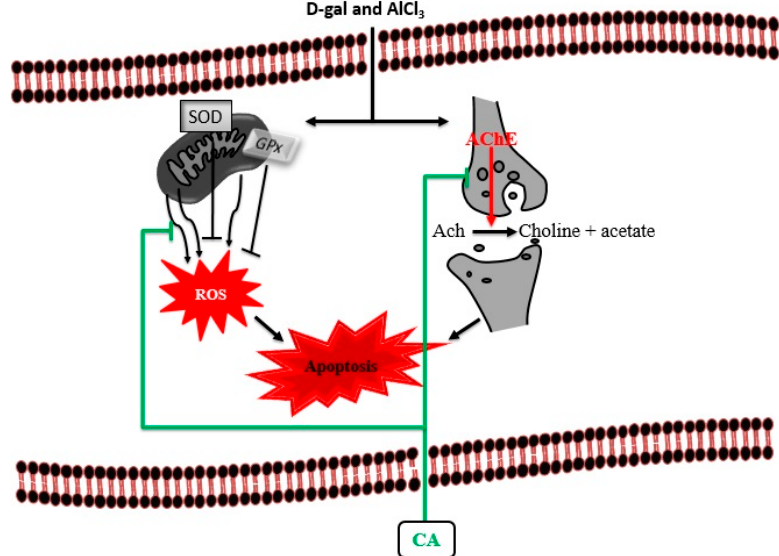
Figure 9. Proposed cognition-enhancing mechanism of CA in D-gal and AlCl 3 induced rats. Administration of D-gal/AlCl 3 induced oxidative stress, cholinergic dysfunction and apoptosis. Administration of CA decreased the levels of AChE and MDA by blocking their activities. CA also